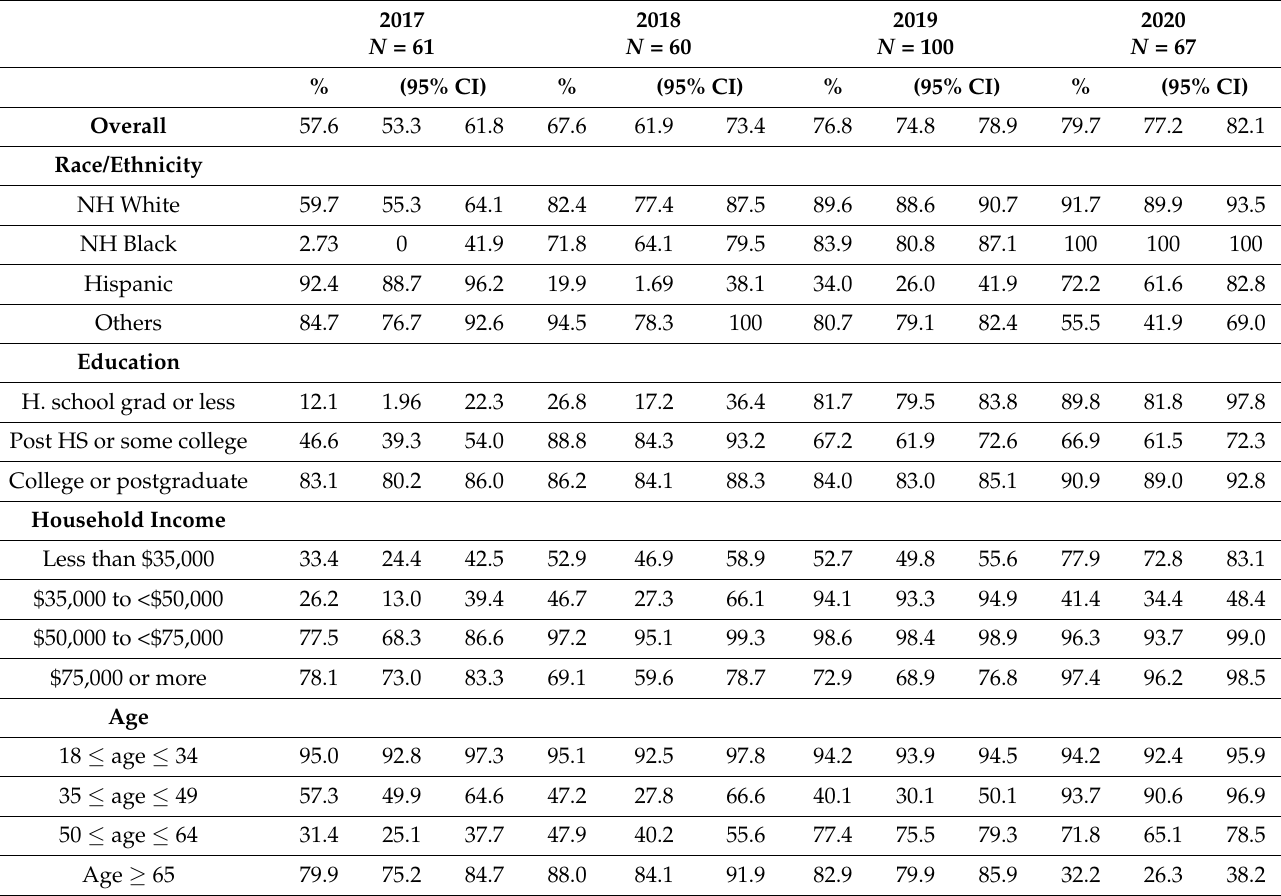
Table 1. Awareness of HPV among gay and bisexual males in the